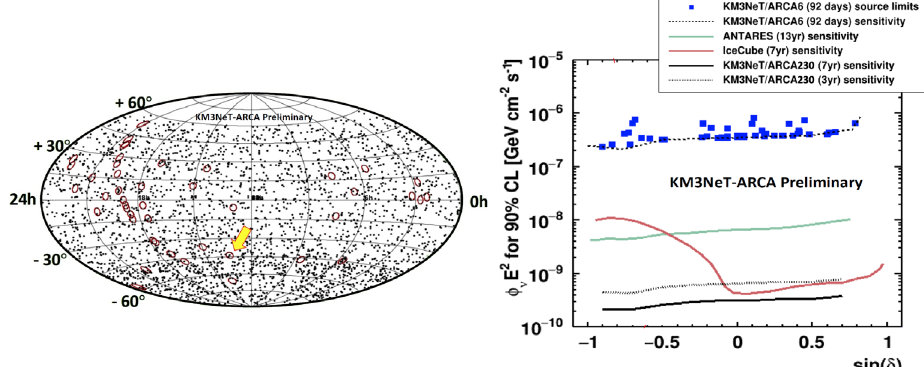
Figure 4. The ARCA detector is growing following the integration activities of the various elements, that are deployed during dedicated marine campaigns. Typically, two campaigns per year are performed, avoiding the winter period. Even if in partial configuration, ARCA is continuously taking data. Two long shutdown periods are reported in red: the first due to an electrical issue in the seabed infrastructure that was fixed with a complete redesign of the Junction Boxes, and the second related to a major upgrade of the shore station which was enlarged to support the full detector with two building blocks. Figure 5. Left: The neutrino sky map of the ARCA 6-line detector with candidate sources indicated with red circles. The yellow arrow points to the source with the best p-value, see text. Right: Upper limits on the cosmic neutrino flux for the candidate sources are reported as blue points. The ARCA sensitivity is displayed as a dashed line and compared to ANTARES and IceCube